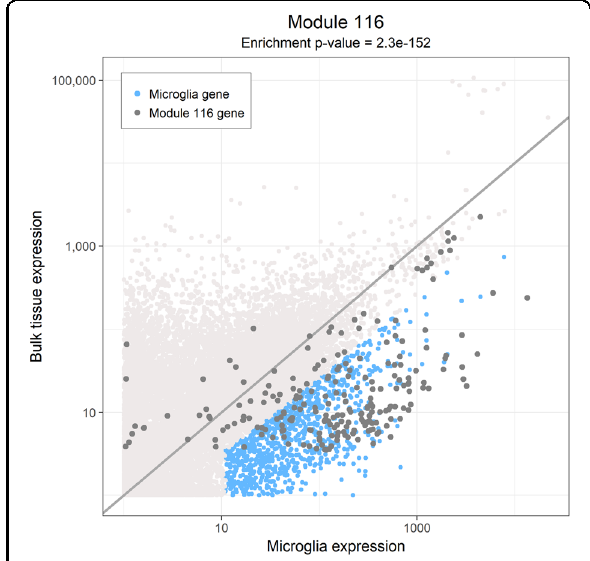
Fig. 1 Enrichment analysis identi fi es m116 as the most microglia- related cortical gene co-expression module. The normalized expression (FPKM) of genes in bulk DLPFC tissue ( Y axis) are compared to their expression (FPKM) in isolated microglia ( X axis). A hypergeometric test was used to assess for the extent of enrichment of m116 genes among the 1030 human microglial genes. Each dot represents one gene. Microglia-enriched genes (blue dots) were identi fi ed based on a fourfold higher expression in isolated microglia compared to bulk tissue. The microglia-enriched genes are likely involved in processes that are relatively speci fi c to microglia. The genes in m116 are displayed in dark gray. Module 116 genes are more highly expressed in isolated microglia when compared to bulk tissue. FPKM fragments per kilobase of transcript per million mapped reads, DLPFC dorsolateral prefrontal